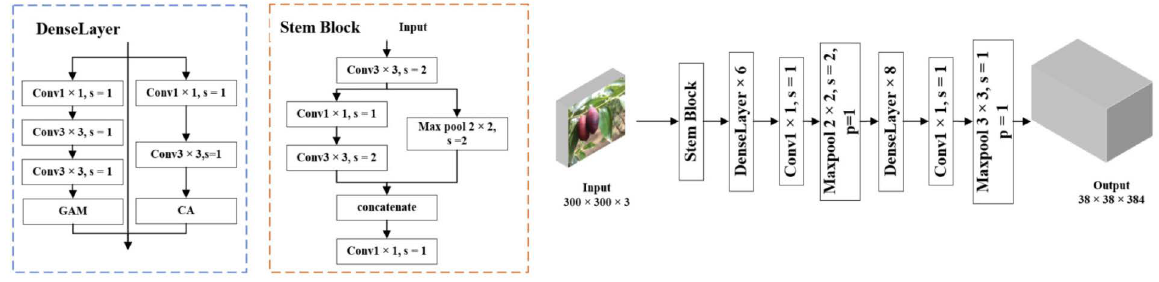
Figure 3. The structure of the improved Peleenet module. s indicates stride; p indicates padding.